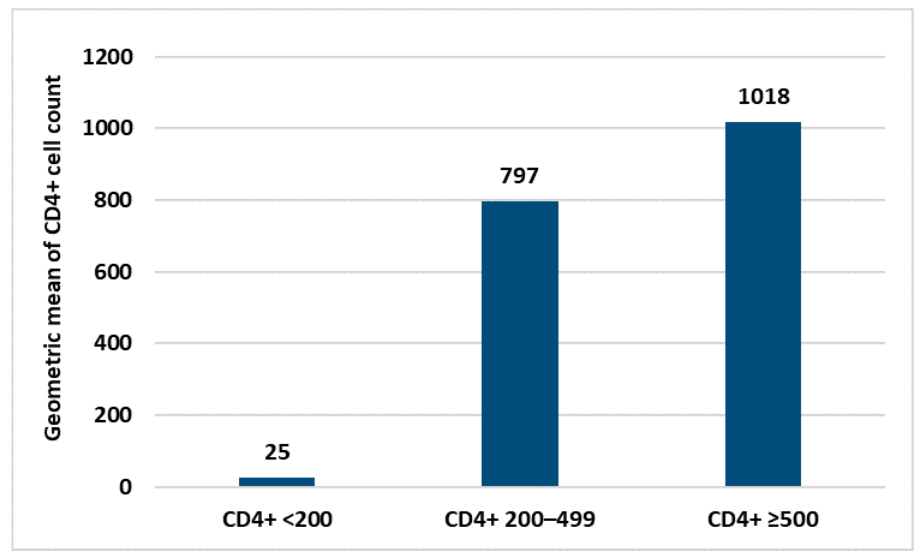
Figure 3. Difference in the immune response according to the mean values of CD4+ count .